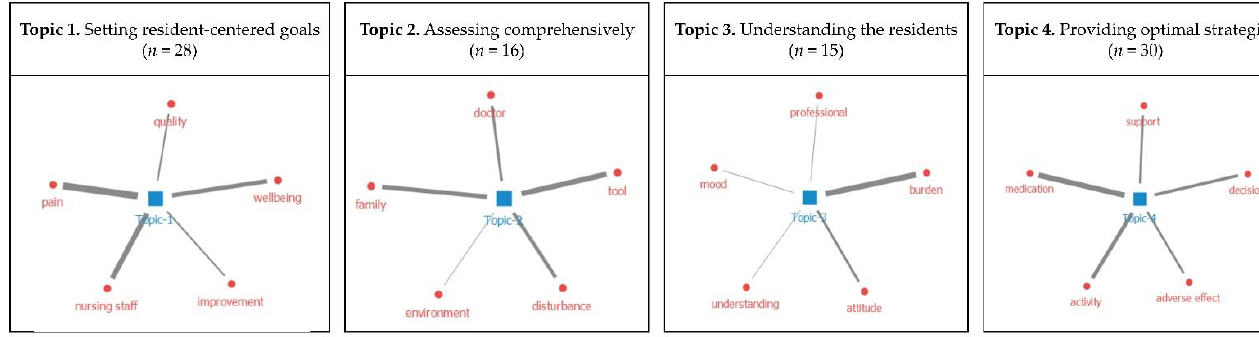
Figure 3. Result of the topic modeling. (Thickness of lines indicates the strength of network between the topic and keywords).